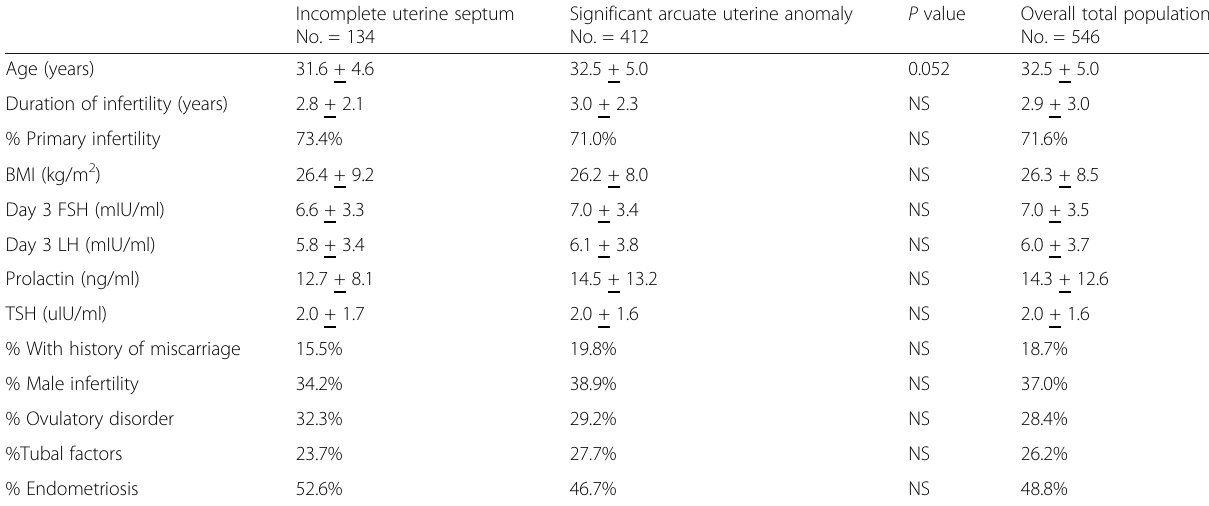
the overall population (16.8 + 3.8 vs 5.4 + 5.6; P < 0.001) (Fig. 6). A correlation analysis between the findings on hysteroscopy and the findings on TV 3D US revealed a low-moderate correlation for IUS ( r = 0.396, P < 0.001), no statistically significant correlation for significant AUA ( r = 0.034, P = 0.668), and a weak correlation for the overall population ( r = 0.202, P < 0.01).